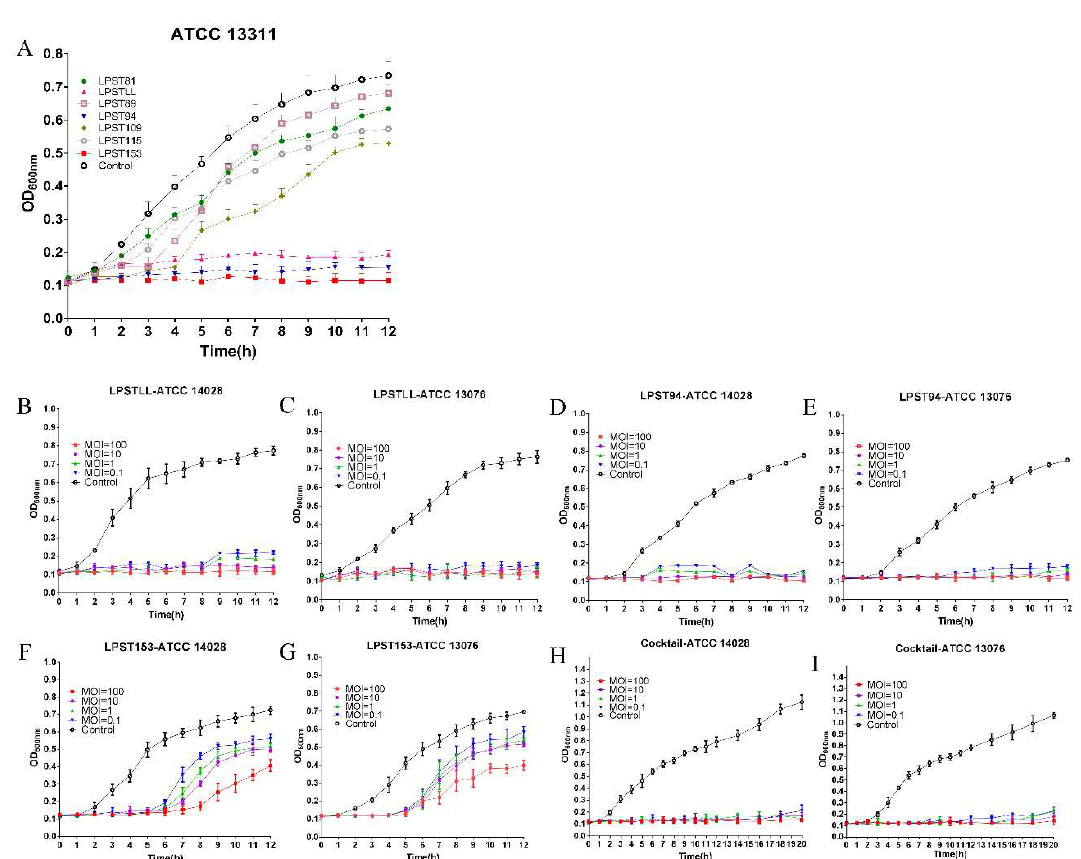
Figure 1. ( A ) Comparison of the lytic ability of selected phages using S. enterica serovar Typhimurium (ATCC 13311) as a host at MOI of 1 in TSB broth; Lytic ability of phage LPSTLL to lyse S. enterica serovar Typhimurium and S. enterica serovar Enteritidis in TSB medium at di ff erent MOIs of 100,